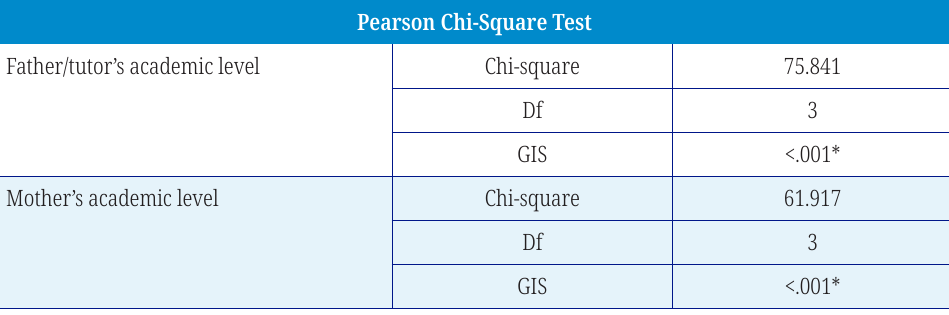
Table 10. Pearson chi-square test: educational level of parents of public/private university